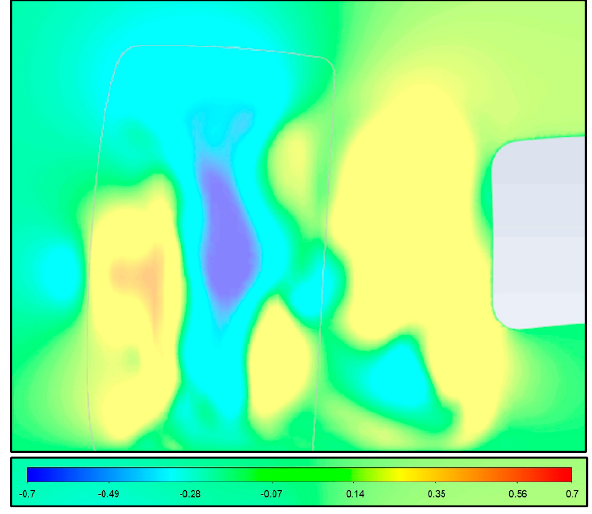
Figure 13. Vertical velocity at plane z = − 1.75 (behind the wheel) (AOA of 30 ◦ , 32 ◦ , and 34 ◦